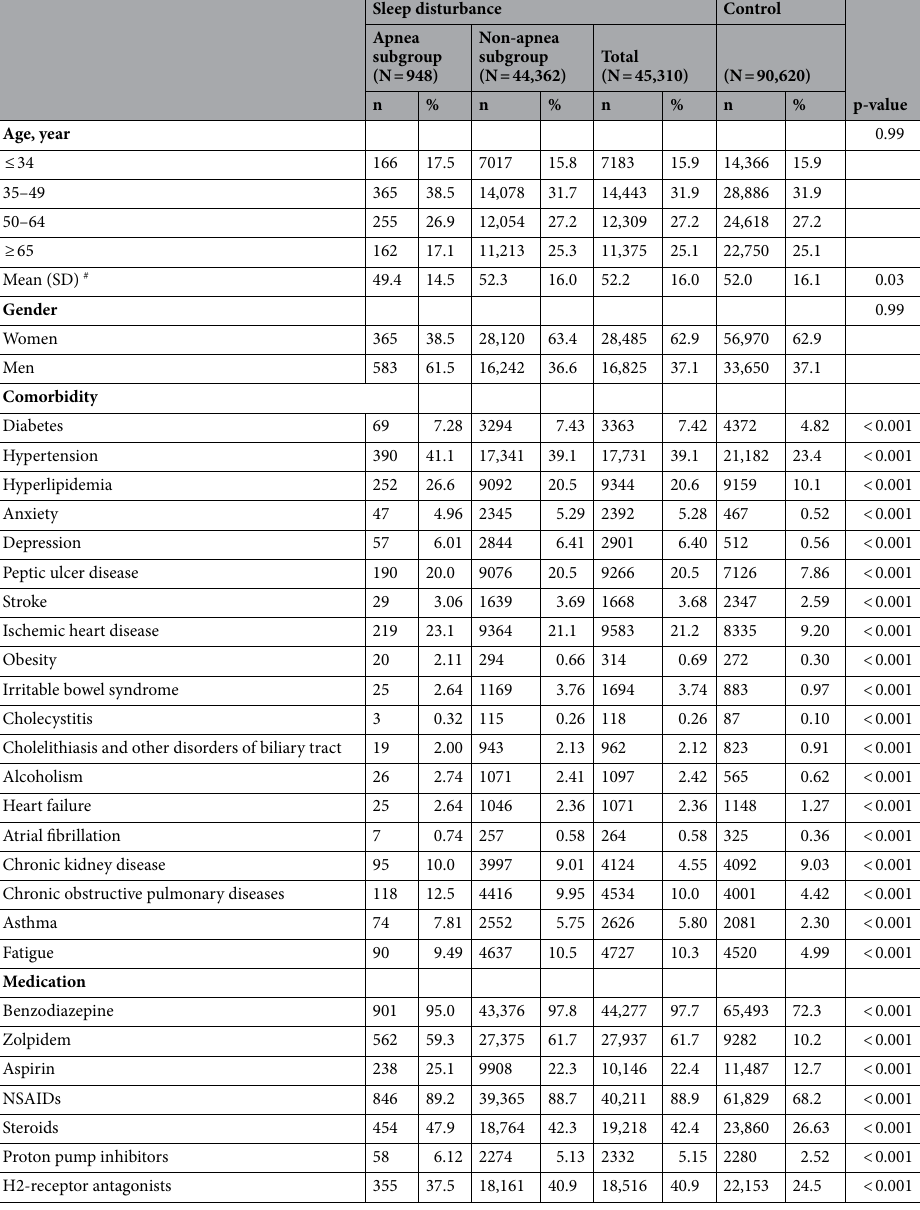
Table 1. Comparison of cohort characteristics. Chi-square test compared to total SD. #